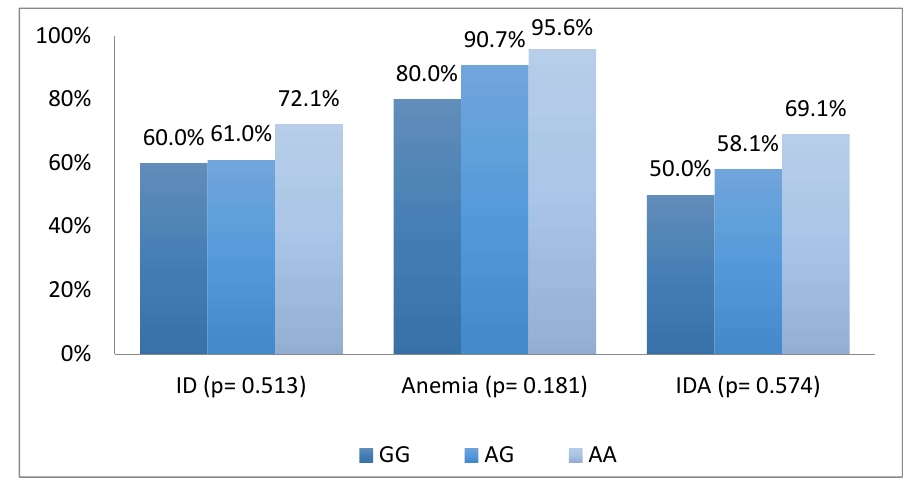
Figure 1. Distribution of Iron deficiency, anemia and iron